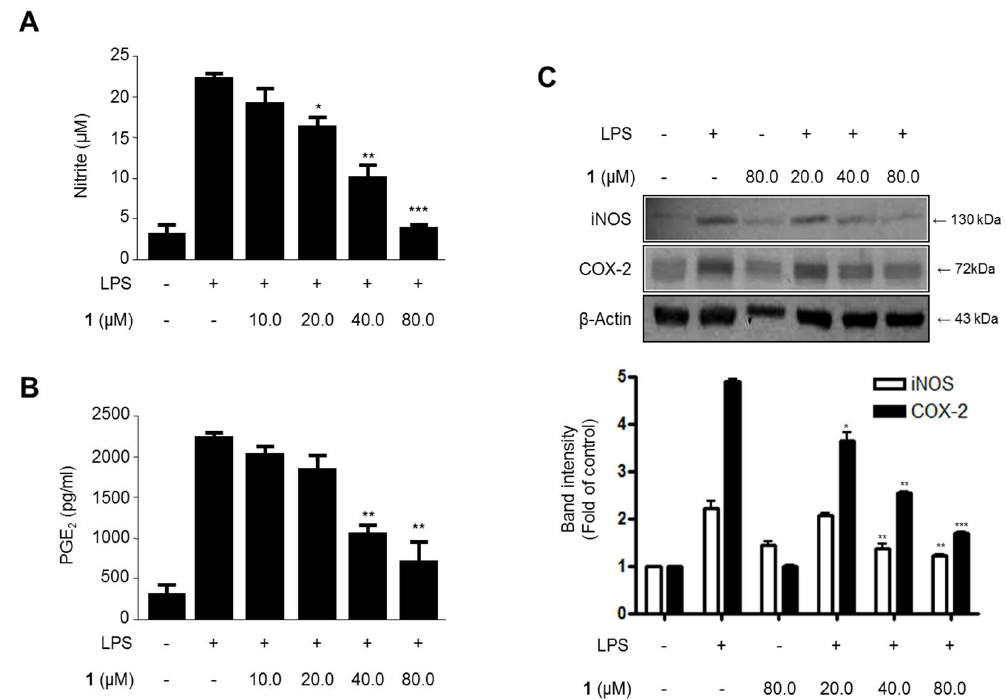
Figure 4. The effects of steppogenin ( 1 ) on nitrite ( A ) and prostaglandin E2 (PGE 2 ) ( B ) production and iNOS and COX-2 expression ( C ) in lipopolysaccharide (LPS)-stimulated BV2 microglial cells. ( A – C ) The cells were pretreated for 3 h with the indicated concentrations of 1 and then stimulated for 24 h with LPS (1 µ g/mL). The data are presented as the mean ± SD of three experiments. The band intensity was quantified by densitometry and normalized to the intensity of the β -actin band; the normalized values are presented below each band. * p < 0.05; ** p < 0.01; *** p < 0.001 compared with the LPS-treated group.